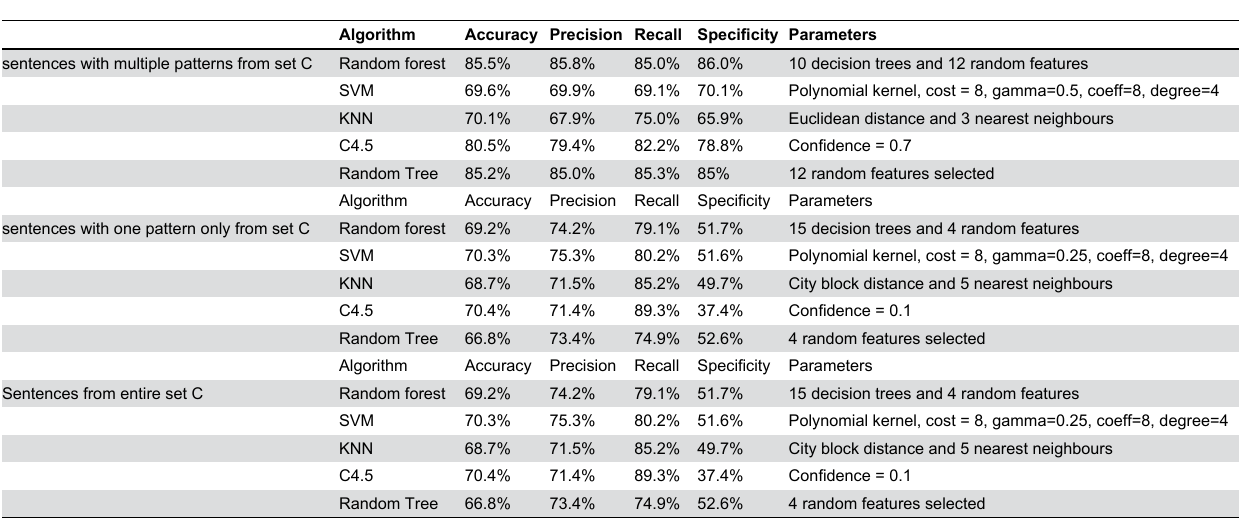
Table 4. Performance of PWM approach after 10-fold cross-validation of algorithms using sentences with multiple patterns from set C, sentences with single patterns only form set C and entire set C after the named entity recognition.